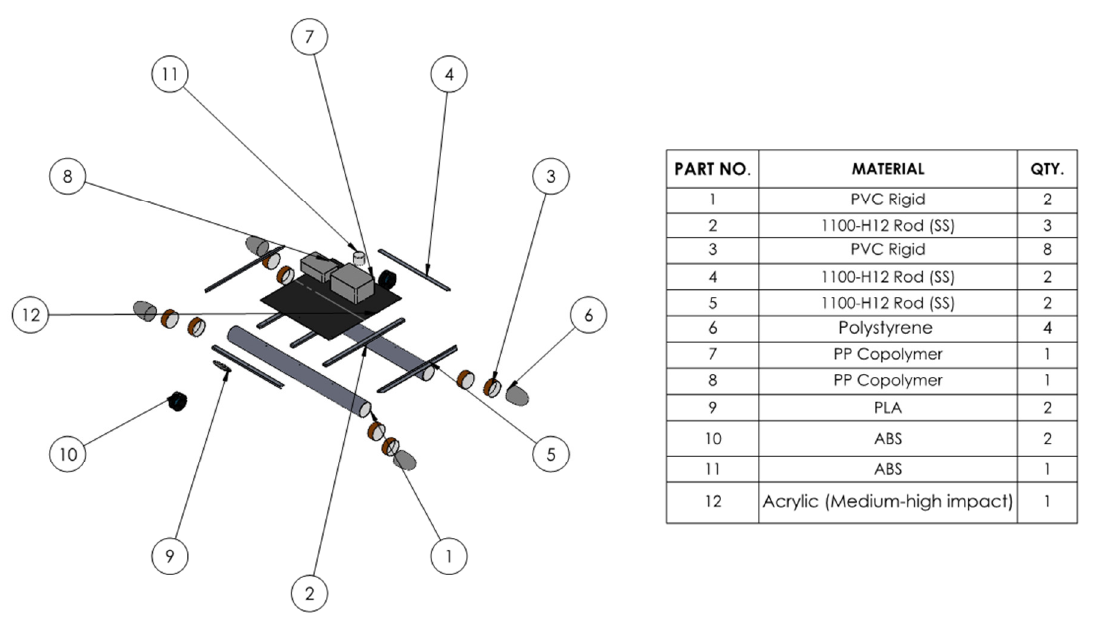
Figure 3. Exploded view dan materials of the proposed